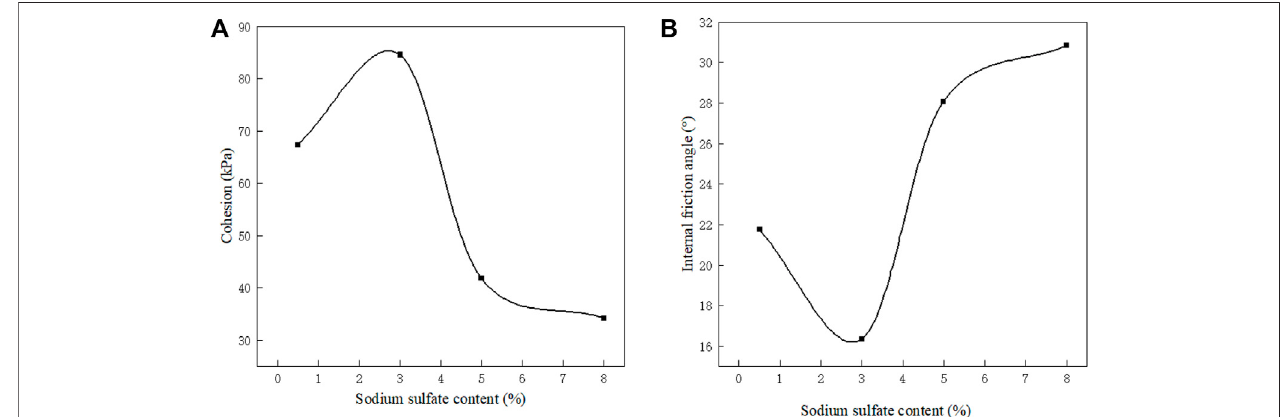
FIGURE 7 | Cohesion and internal friction angle of sulfate soil with different sulfate content.